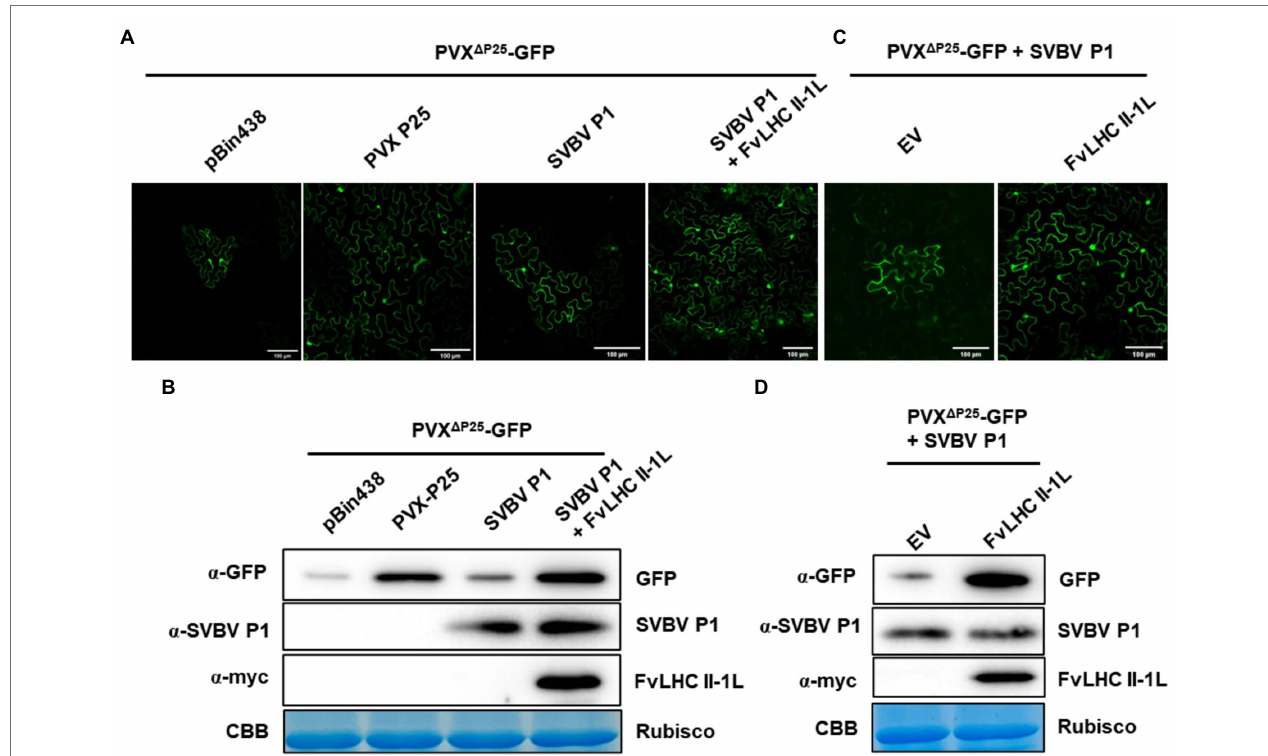
FIGURE 4 | FvLHC II-1L assists SVBV P1 in complementing movement-defective potato virus X (PVX). (A) FvLHC II-1L promotes SVBV P1 to complement movement-defective PVX (PVX Δ P25 -GFP) in N. benthamiana . PVX Δ P25 -GFP was co-infiltrated with pBin438 empty vector, P25, SVBV P1, or SVBV P1 and FvLHC II-1L in N. benthamiana . GFP fluorescence was observed at 3 dpi. Bar scale = 100 μ m. (B) Western blot analysis of GFP, SVBV P1, or FvLHC II-1L protein accumulation in infiltrated leaves at 3 dpi. α -GFP, α -SVBV P1, and α -myc antibodies were used to detect the accumulation of GFP, SVBV P1, and FvLHC II-1L, respectively. Coomassie Brilliant Blue-stained RuBisCO was used as the loading control. (C) FvLHC II-1L promotes SVBV P1 to complement PVX Δ P25 -GFP in FvLHC II-1L transgenic N. benthamiana . PVX Δ P25 -GFP was co-expressed with SVBV P1 in empty vector (EV) or FvLHC II-1L transgenic N. benthamiana . GFP fluorescence was observed at 3 dpi. (D) The accumulation of GFP, SVBV P1, and FvLHC II-1L proteins in infiltrated leaves was detected via western blotting at 3